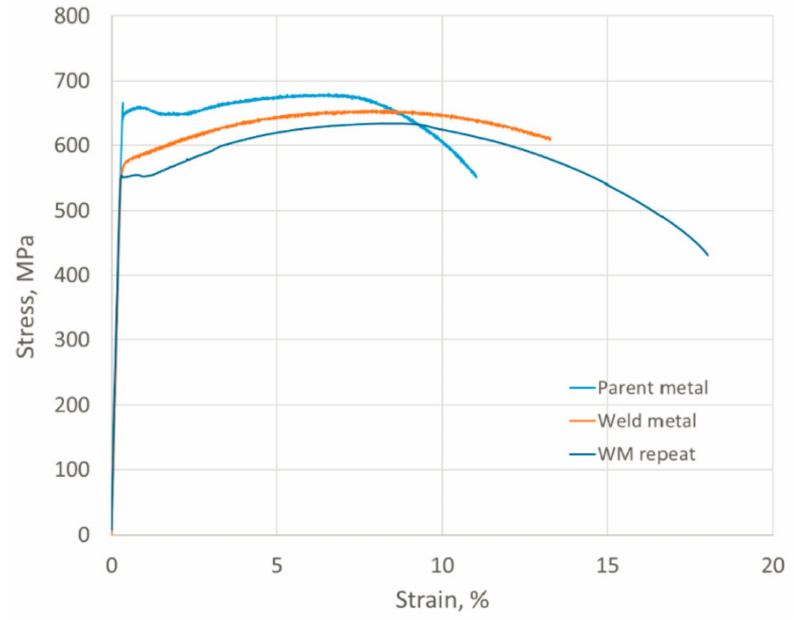
Figure 6. Stress–strain curves generated from round tensile specimen from the parent metal, and from two all-weld metal round tensile specimens, tested at room